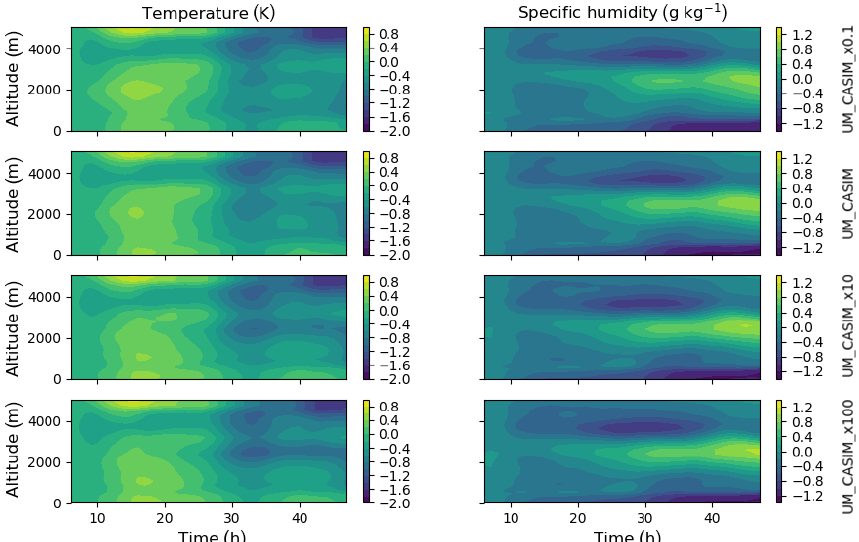
Figure 13. Hovmöller plots showing the temporal evolution of domain mean temperature (left) and specific humidity (right). These show the difference between the mean temperature or specific humidity at each time in the simulation and the first time point after the 6h spin-up. Each row is for a different simulation, with aerosol increasing from top to bottom down the